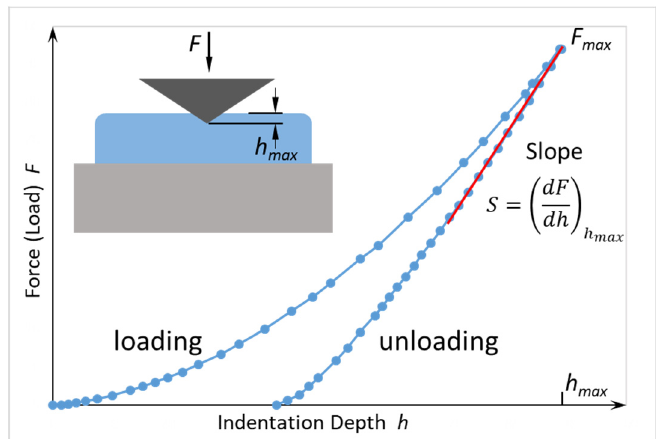
Figure 5. Typical nanoindentation curve for a load–unload cycle. The elastic modulus and hardness derive from the unloading part. The inset schematically shows the indenter tip pushed into the sample.